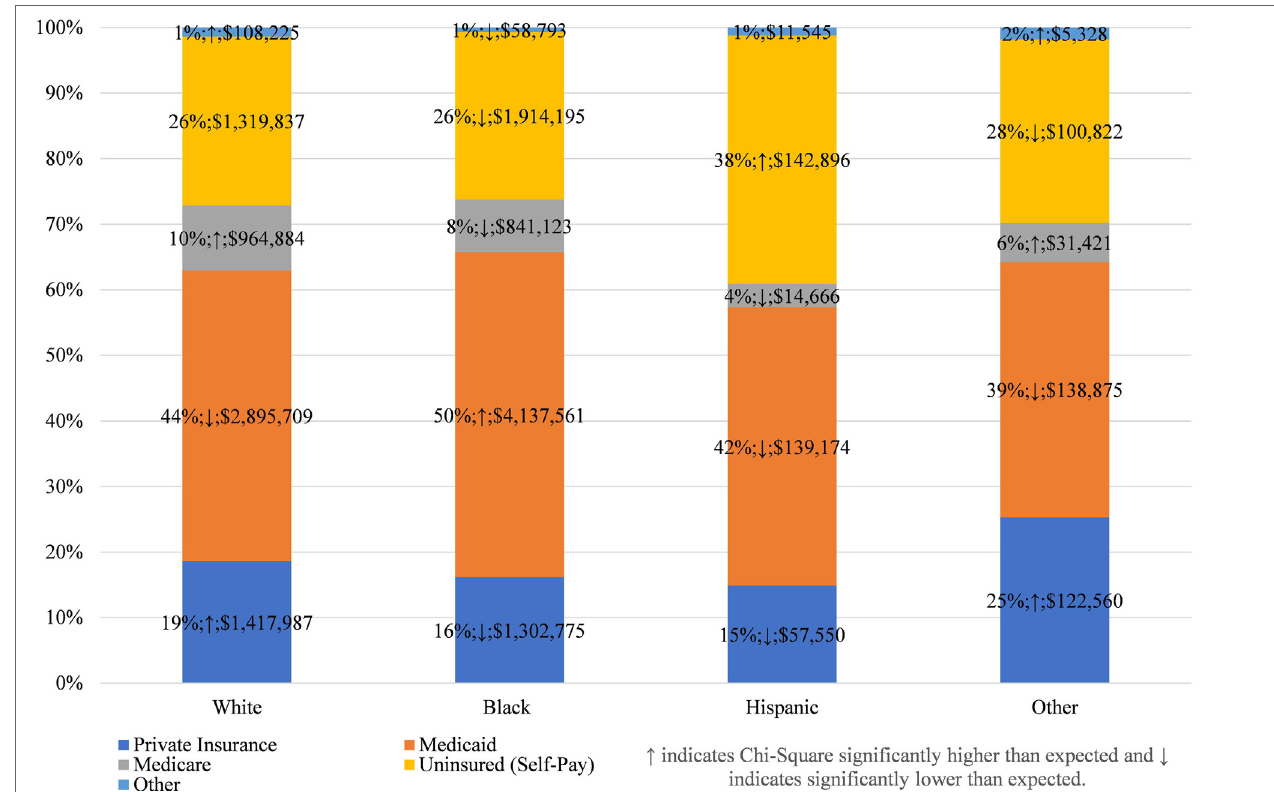
FigUre 1 | Expected payers of dental/oral health related conditions discharges, by race, in Maryland